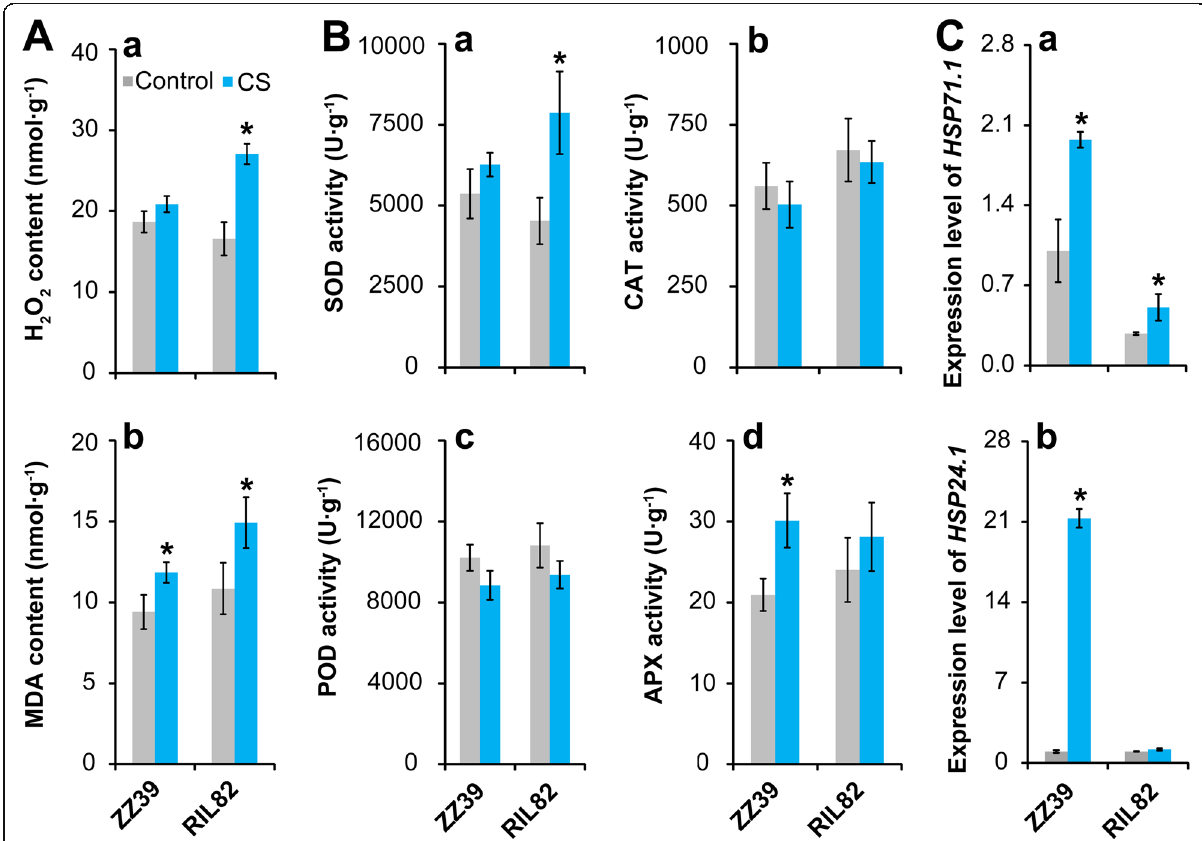
Fig. 2 Effects of cold stress on antioxidant enzyme activities, H 2 O 2 and MDA contents and heat shock proteins in rice leaves. a , H 2 O 2 and MDA; b , Antioxidant enzyme activities; c , Expression levels of heat shock proteins. Vertical bars denote standard deviations ( n = 3). A t -test was conducted to compare the difference between control and cold stress within a cultivar. * denotes P <